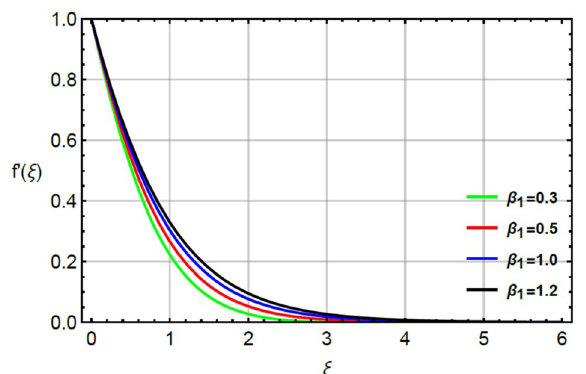
Figure 3. Character of β 1 on f ′ .